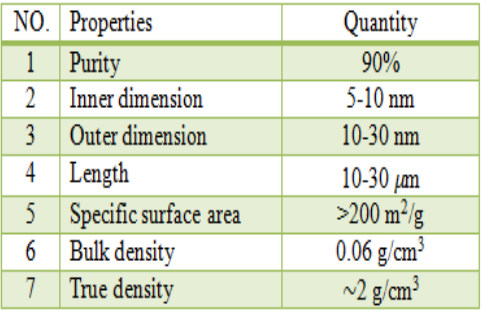
Table 1: Shows properties of MWCNTs.